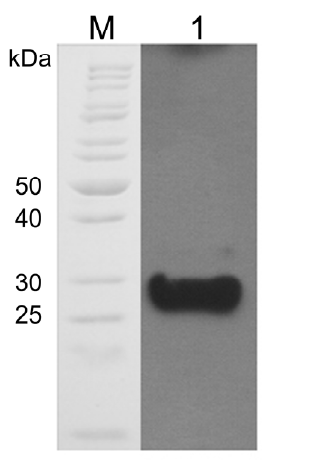
Figure 3. Western blot analysis of MnSOD probed with rabbit anti-Cu/Zn SOD antibody. Lanes: M, standard protein marker; 1, MnSOD.